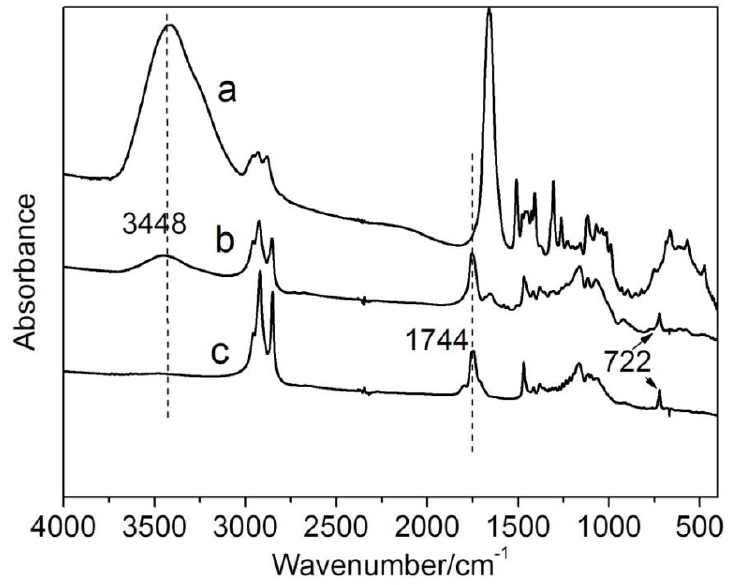
Figure 2. FTIR of microcrystal cellulose (MCC) ( a ), cellulose state (DS = 2.45) ( b ) and Cellulose tri-stearate (CTs) ( c